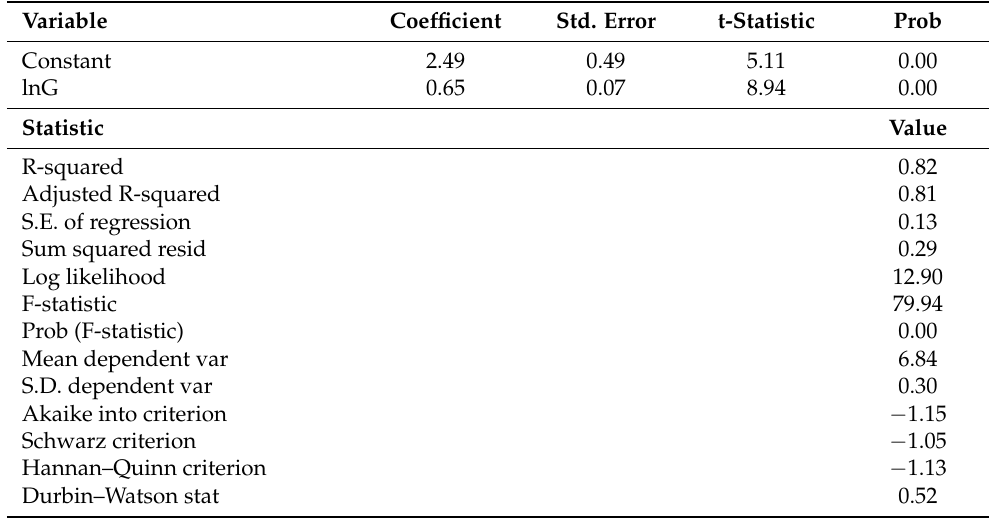
Table 4. Estimated results of the regression